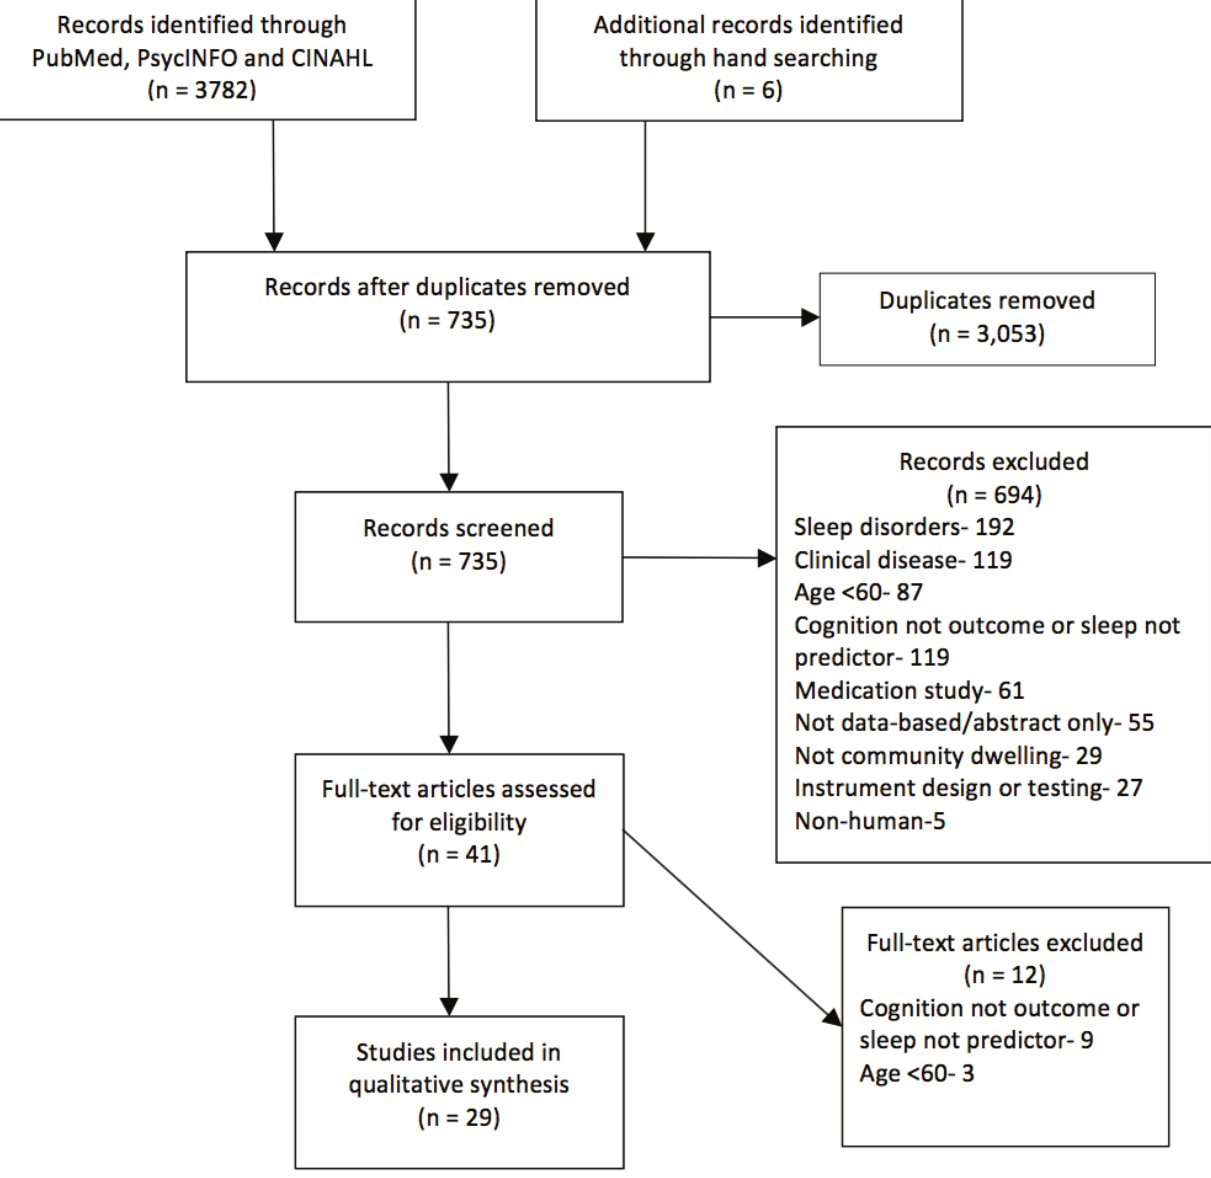
Figure 1. Flow diagram of literature review search for sleep and cognition in older